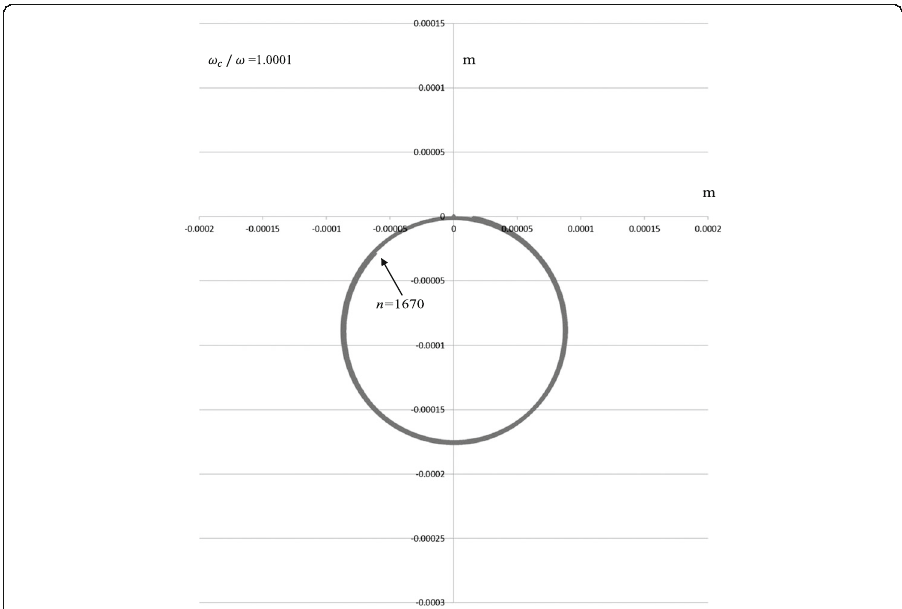
Fig. 11 The gyration orbit of a nonrelativistic electron. The physical conditions are the same with in Fig. 9, except for the following change: c " = (3 × 10 8 m / sec ) 2 → (3 × 10 8 × 10 6 m/sec) 2